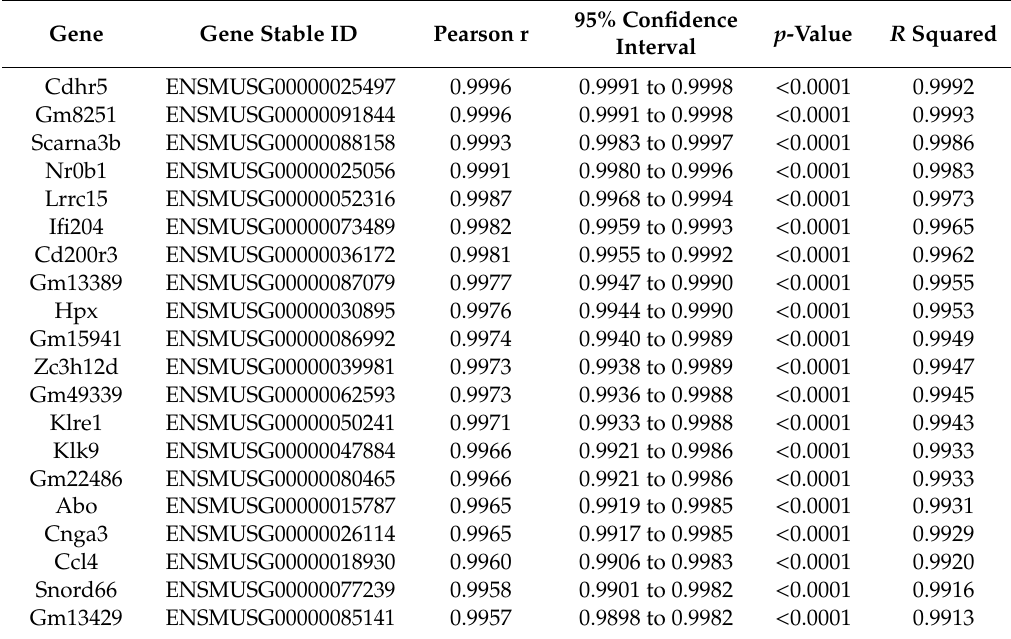
Figure 3. Gene ontology analysis for the genes statistically correlated to IL-1RN in the model of cortical spreading depression (CSD)-induced migraine. ( A ) Most enriched biological processes; ( B ) Most enriched molecular functions. FDR: False Discovery Rate Table 1. Top 20 genes statistically correlated to IL-1RN .